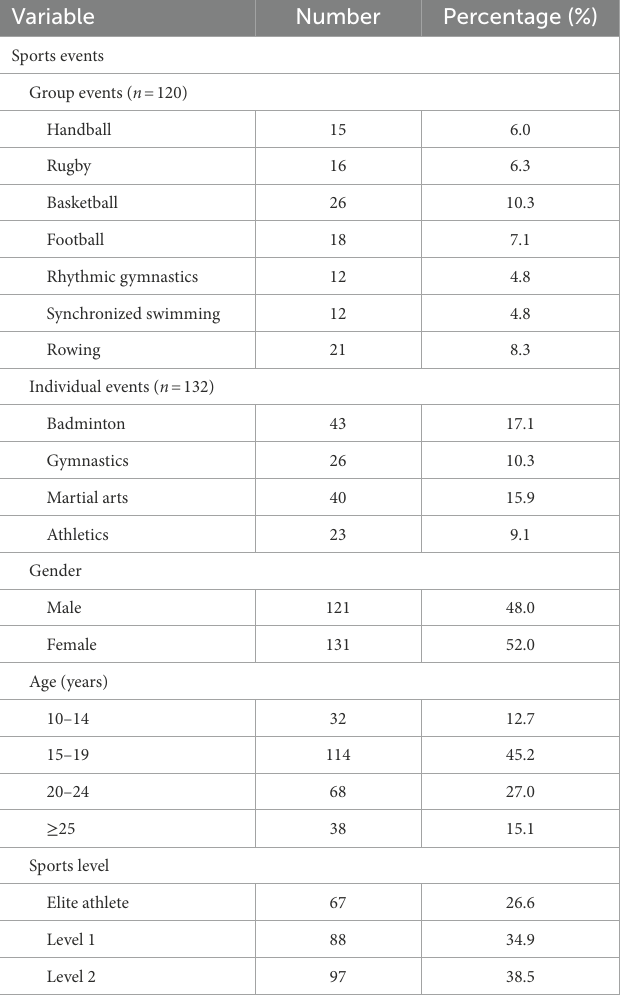
TABLE 1 Demographic characteristics of the participants ( n =